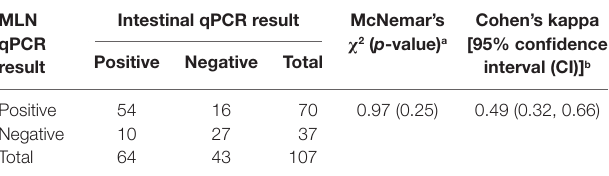
FigUre 2 | Line plot showing median log 10 DNA quantity and interquartile range of Mycobacterium avium subspecies paratuberculosis DNA quantified in mesenteric lymph node and intestinal tissues against the respective histopathological lesion score (according to Pérez et al.) in these tissues. In intestines, the lesion type 3 was further distinguished as subtypes 3a, 3c, and 3b.